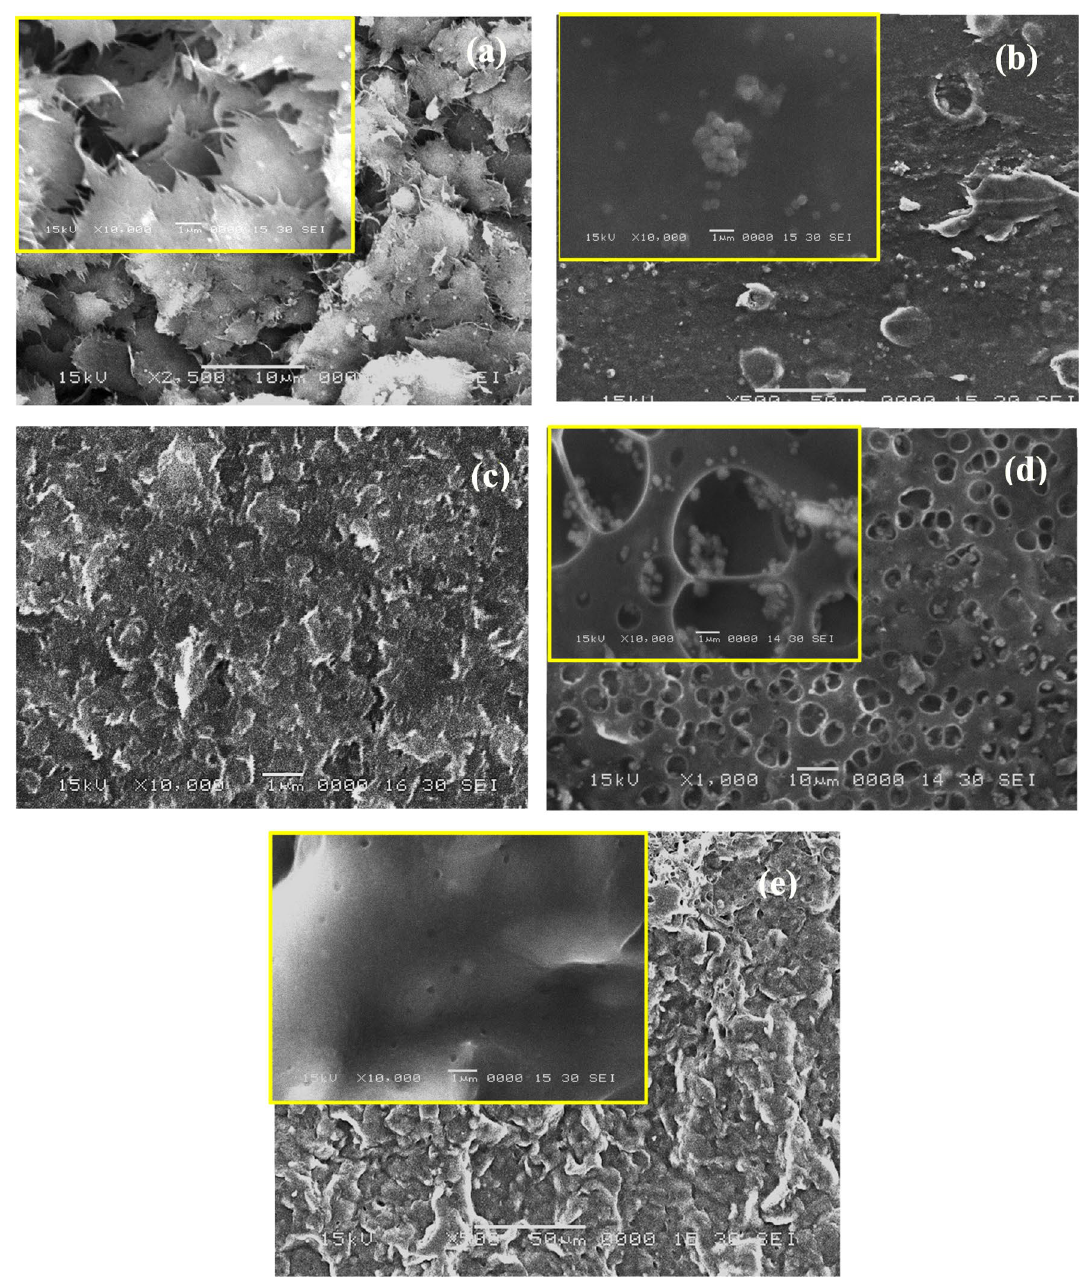
Figure 3. SEM images of: ( a ) purified SWCNTs, ( b ) pure P3HT, ( c ) P3HT/10% SWCNTs, ( d ) P3HT/25% SWCNTs and ( e ) P3HT/50% SWCNTs. The inset images are the samples at high